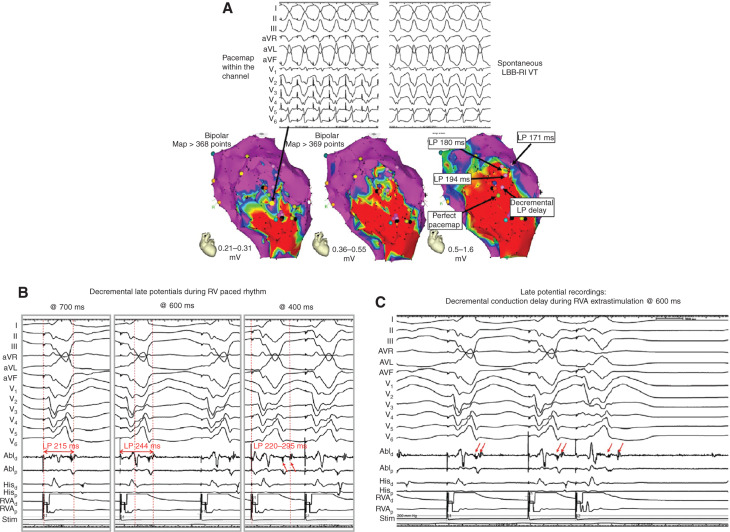
Identification of VT-conducting channel. A: Catheter mapping in a patient with a large anterior myocardial infarction. The spontaneous VT has a left bundle branch block–right inferior (LBB-RI) QRS morphology. The endocardial bipolar voltage map showed a large anterior scar. The color gradient adjustments of the bipolar voltage correspond with 0.5 mV to 1.6 mV, 0.35 mV to 0.55 mV, and 0.21 mV to 0.31 mV. A potential VT-related conduction channel can be identified at a color threshold range of 0.21 mV to 0.31 mV. Recordings from inside this channel during differential pacing demonstrate progressively late potentials from the border zone into the scar area. Pacing from within this channel with decremental late potentials/LAVAs resulted in a perfect pacemap suggestive of a potential VT isthmus site. B: With right ventricular pacing at different rates, delayed and fractionated signals were recorded within the channel. Decremental prolongation of the pacing stimuli-to-potential intervals were noted with increasing pacing rates, suggestive of local conduction delay into the channel. C: With right ventricular premature stimulation, decremental multicomponent and fractionated local electrograms were also noted within the channel, suggesting slow conduction into the potential VT isthmus site. LAVAs: local abnormal ventricular activities; LP: late potential; VT: ventricular tachycardia. Adapted from Al-Ahmad AA, Callans DJ, Hsia HH, et al. Hands-On Ablation: The Experts’ Approach. 2nd ed. Minneapolis, MN: Cardiotext Publishing, LLC; 2017. Used with permission from Cardiotext Publishing.